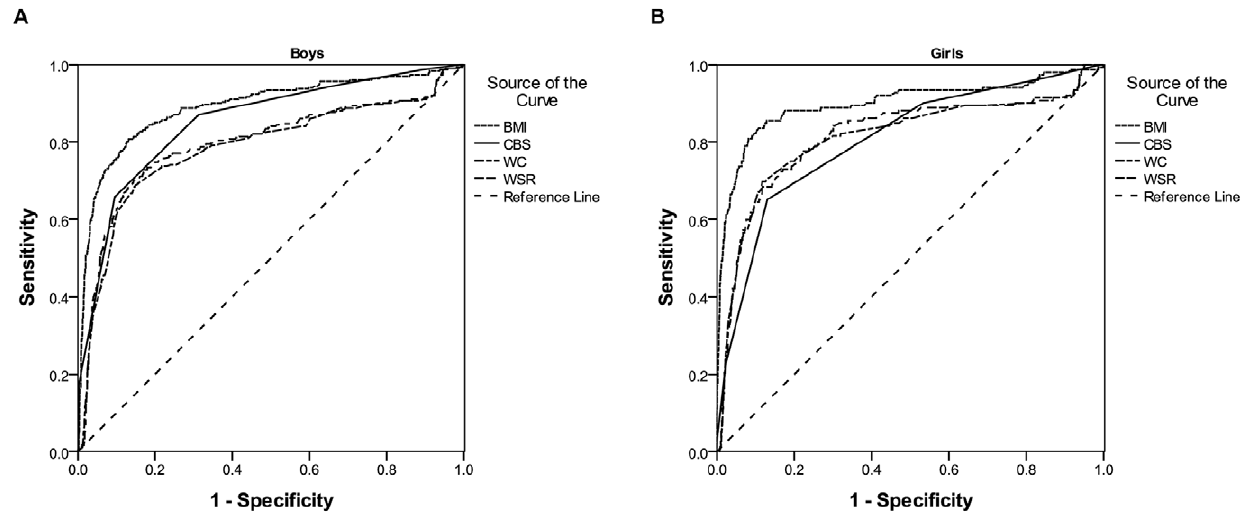
Figure 2. Receiver operating characteristic (ROC) curves for overweight/obesity in boys and girls. Self-reported BMI had the greatest AUC for both sexes. In boys, CBS had a higher AUC than WSR and WC, while in girls the AUCs of CBS, WSR and WC were comparable. (A) AUC for boys: self-reported BMI (0.89); CBS (0.85); self-reported WC (0.80); self-reported WSR (0.78). (B) AUC for girls: self-reported BMI (0.90); CBS (0.81); self-reported WC (0.82); self-reported WSR